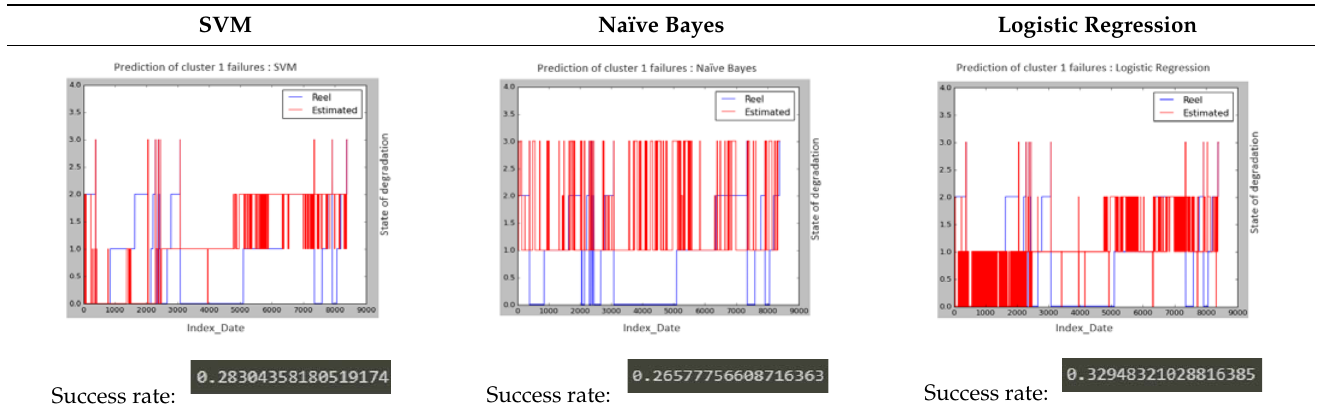
Table 3. The results of the prediction of the degradation state (example of cluster 1) for the three algorithms.